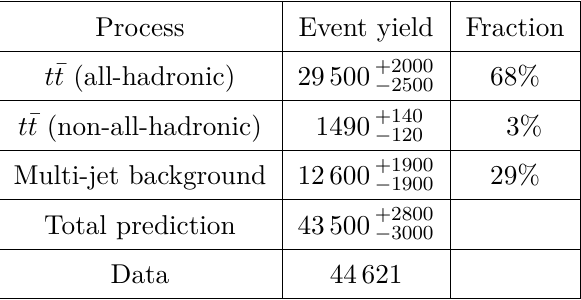
Table 6 . Event yields for data, signal and background processes after the signal region selection. Uncertainties are quoted as the sum in quadrature of statistical and detector-level systematic uncer- tainties. The composition of the selected events is also given in terms of the fractional contribution of the signal and background processes to the total yield.